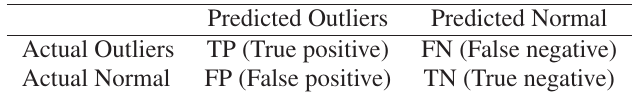
Table 1. Performance